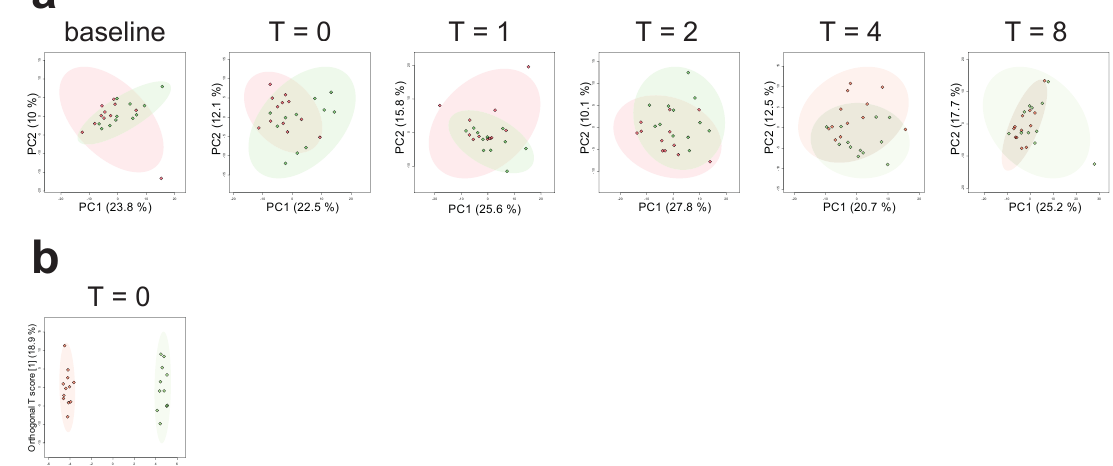
Figure 3. The plasma metabolome in trained and untrained subjects. ( a ) Principal component analysis (PCA) of the plasma metabolome at baseline (one hour before LPS administration, T = 0 (just before LPS administration), and 1, 2, 4, and 8 h post-LPS administration in the control (red dots) and trained (green dots) group. The shaded areas indicate the 95% confidence intervals. ( b ) Orthogonal partial least squares-discriminant analysis (OPLS-DA) of the plasma metabolome at T = 0 in the control (red dots) and trained (green dots) group. The shaded areas indicate the 95% confidence